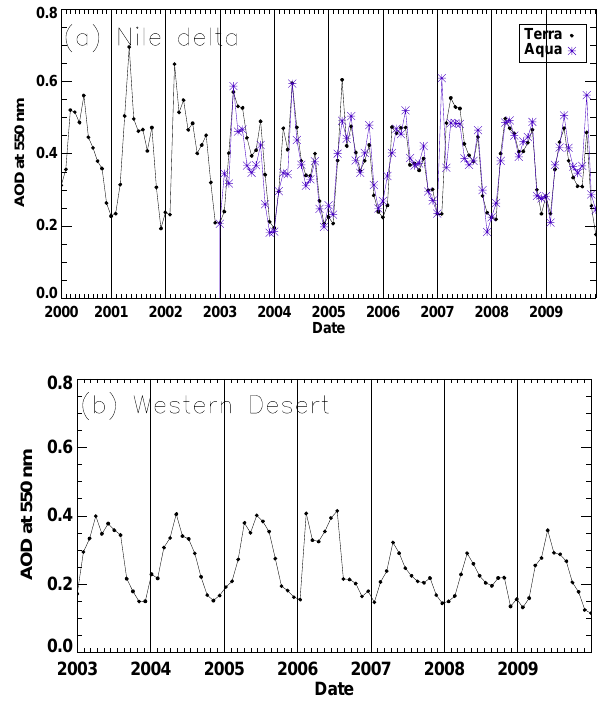
Fig. 2. (a) Time series plot of MODIS AOD at 550nm over the Nile Delta from Terra and Aqua and (b) Western desert using Aqua deep blue